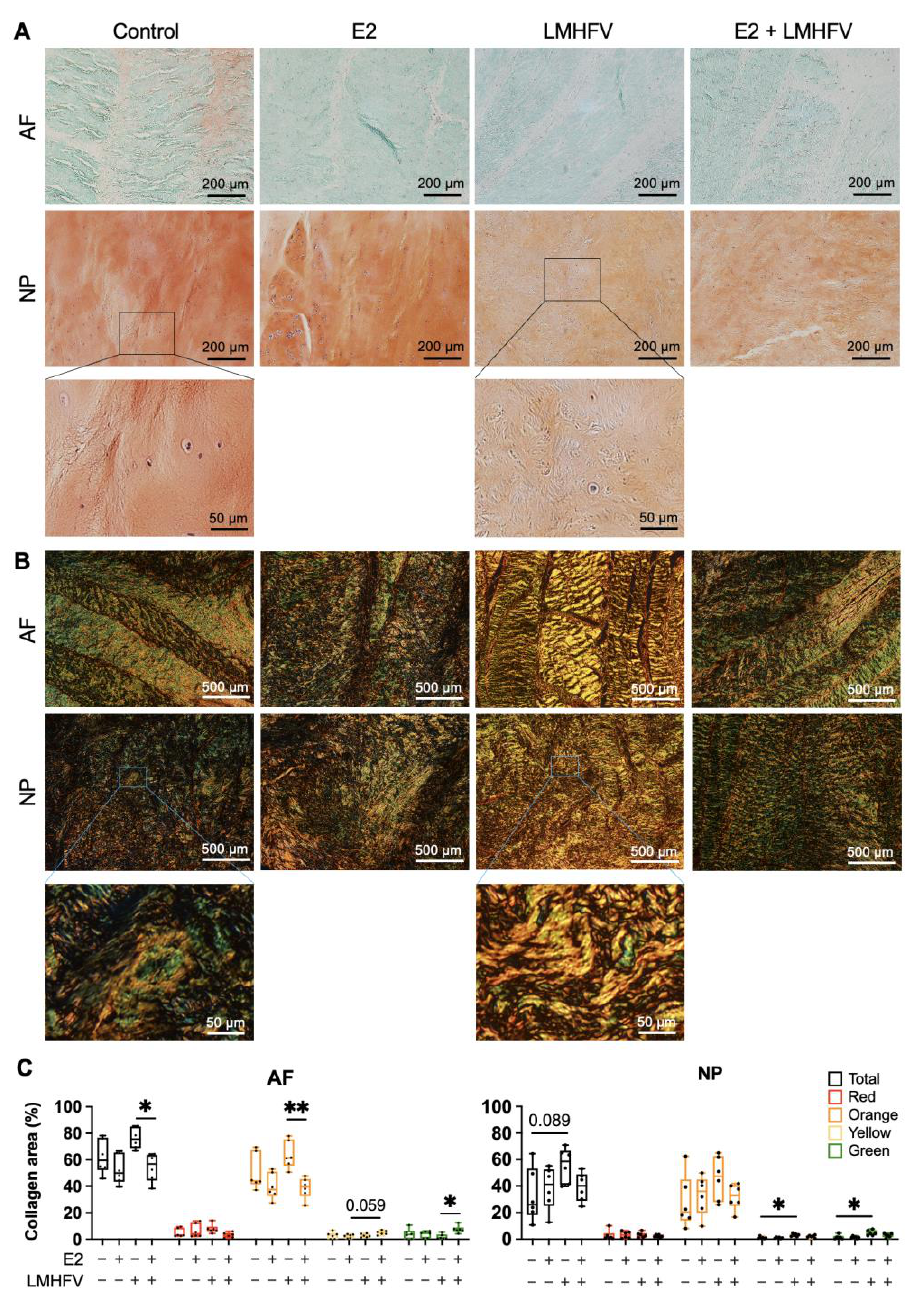
Figure 6. Histological analysis of control, E2, LMHFV and E2 + LMHFV IVD tissues after 21 days of culture. Sagittal IVD sections were stained with ( A ) safranin O/fast green for the detection of proteoglycans (proteoglycans are stained orange and collagens are counterstained green; scale bar, 200 μm) or ( B ) picrosirius red for the detection of collagens. The colour range visualised under polarised light microscopy corresponds to relative fibre thickness from thin and less mature green fibres to increasingly thicker and more mature yellow, orange and red fibres (scale bar, 500 μm). AF and NP regions of one representative donor are depicted. ( C ) Quantification of the relative percentage of collagen fibres in the AF and NP regions of the picrosirius red-stained sections. Results are presented in box plots ( n = 6 IVDs/group). * p < 0.05, ** p < 0.01.